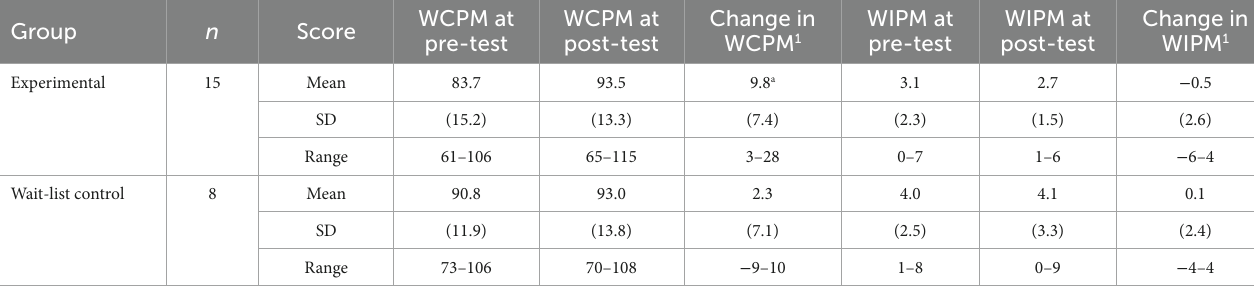
TABLE 2 Mean, standard deviation, and range WCPM and WIPM scores at pre-and post-test by group. Group n Score